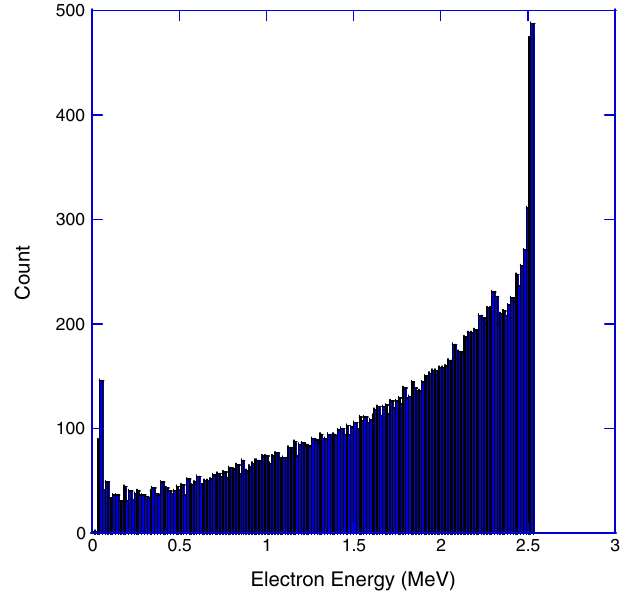
FIG. 5. PARMELA -predicted energy spectrum of field-emitted electrons at cavity pickup loop power of 702